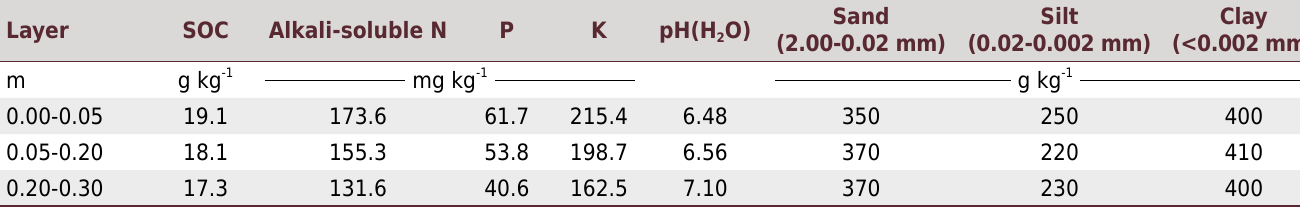
Table 1. Soil properties before treatment